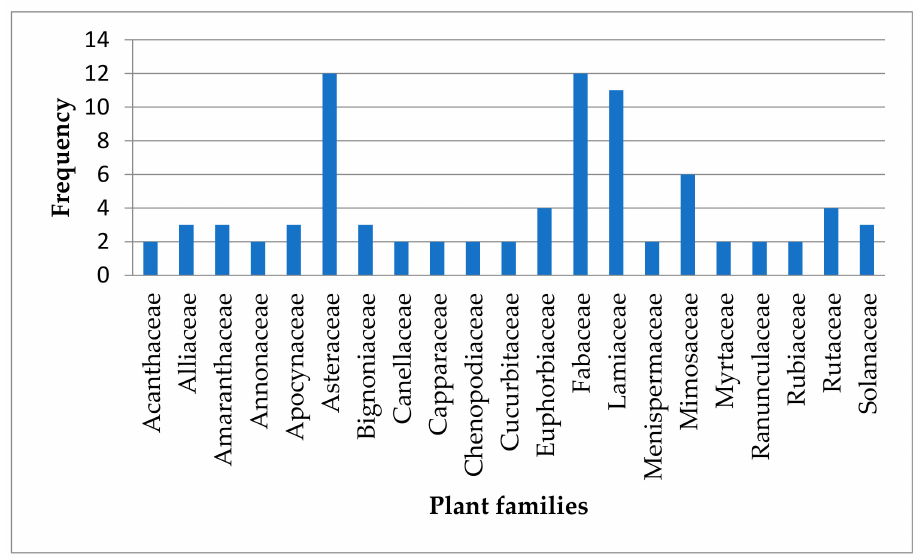
Figure 2. Frequency ( n ) of plant families mentioned ( n ≥ 2) as remedy for managing headache in Africa. The remaining plant families ( n = 34) that were mentioned once are listed in Table